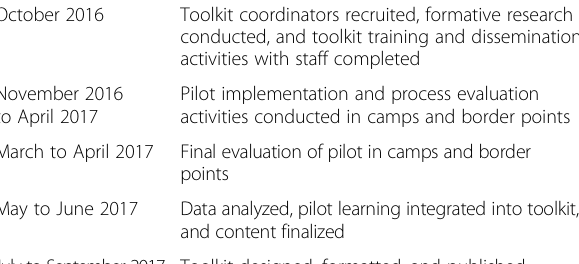
Table 1 Toolkit development process